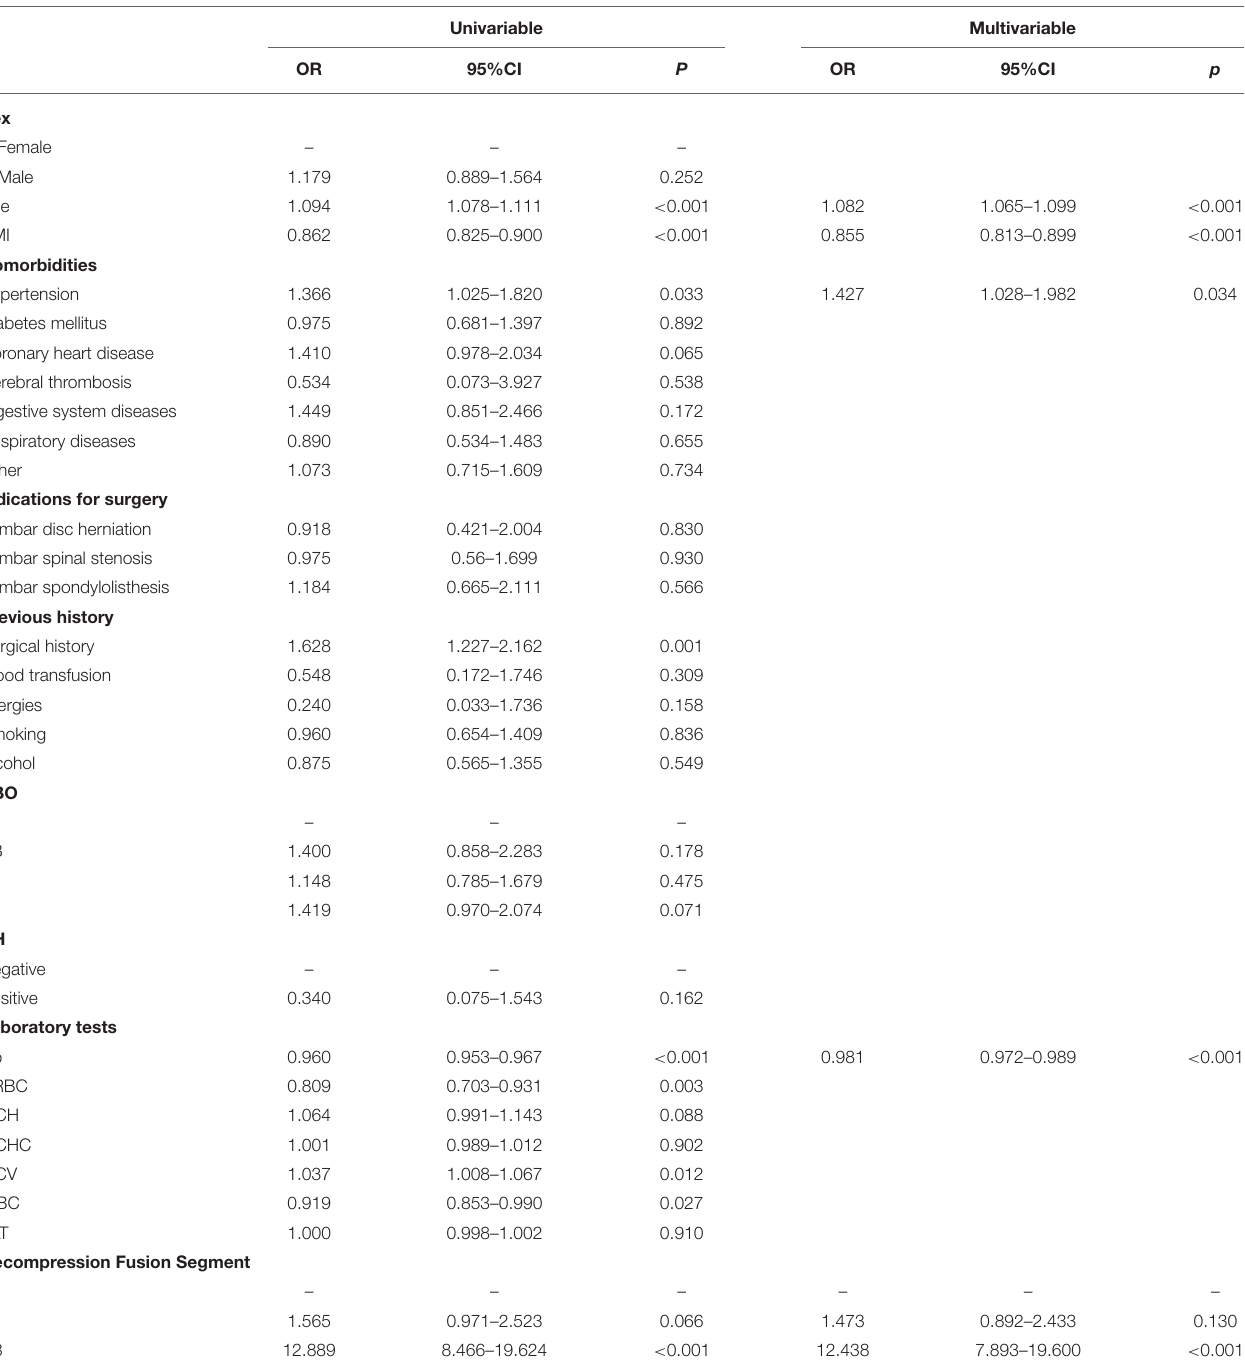
TABLE 2 | Univariate and multivariate logistic analyses for risk factors of blood